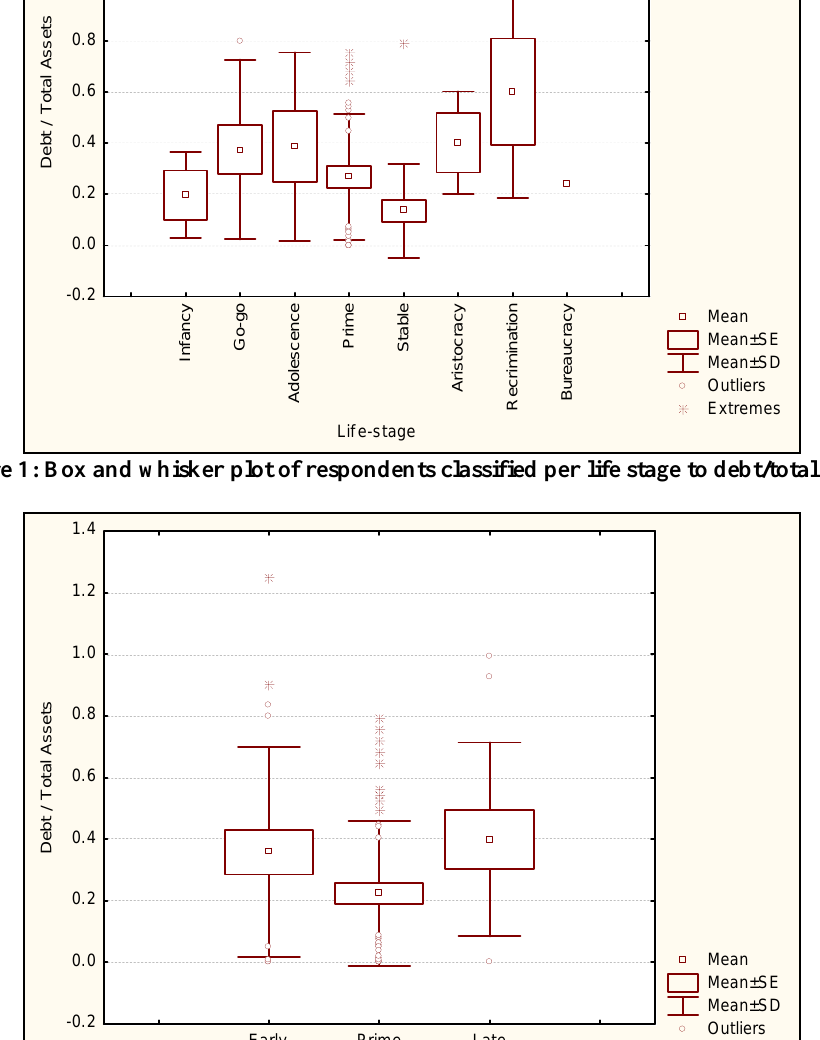
Interpretation of